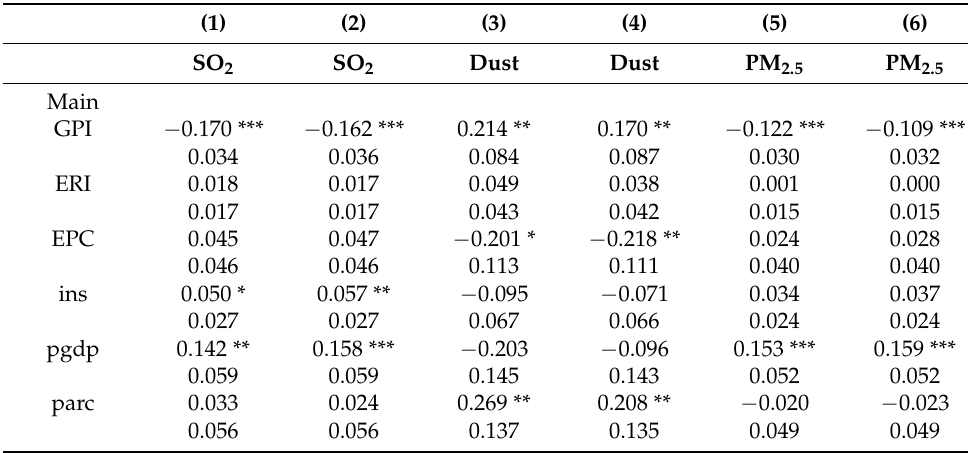
Table 5. Results of spatial Durbin model